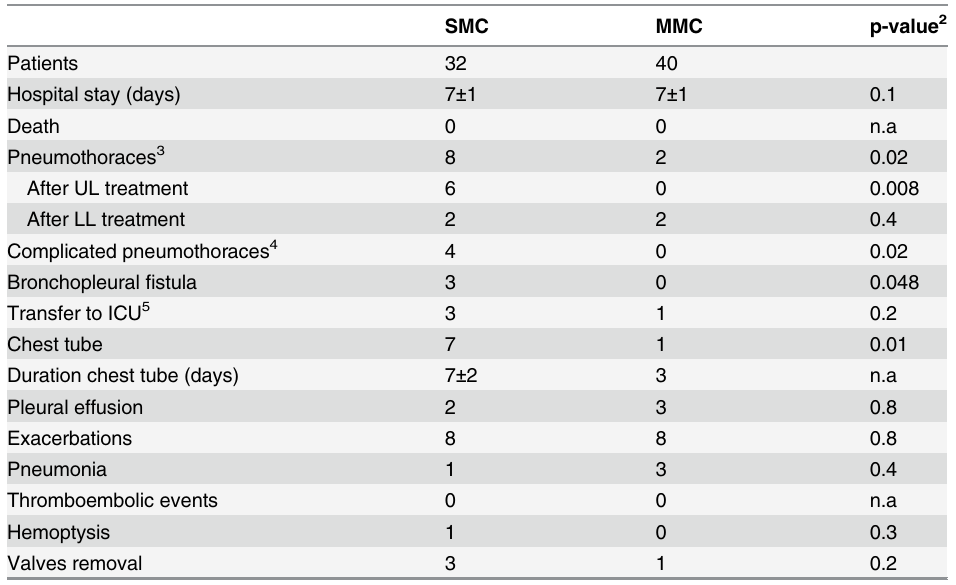
Table 2. Complications during hospitalization 1 .